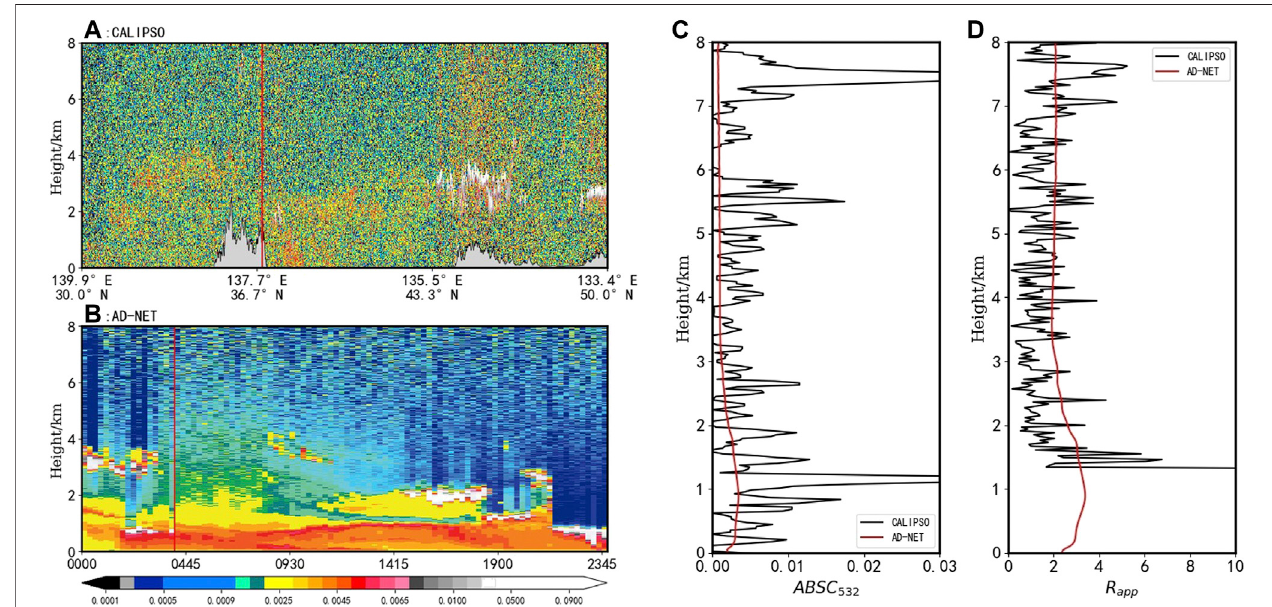
FIGURE 8 | Same in Figure 7 , while the date is on March 21st, 2020.